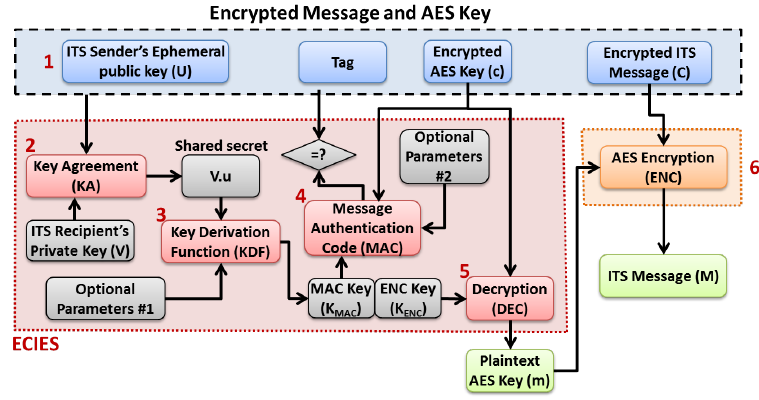
Figure 8. ECIES with AES based Message Decryption